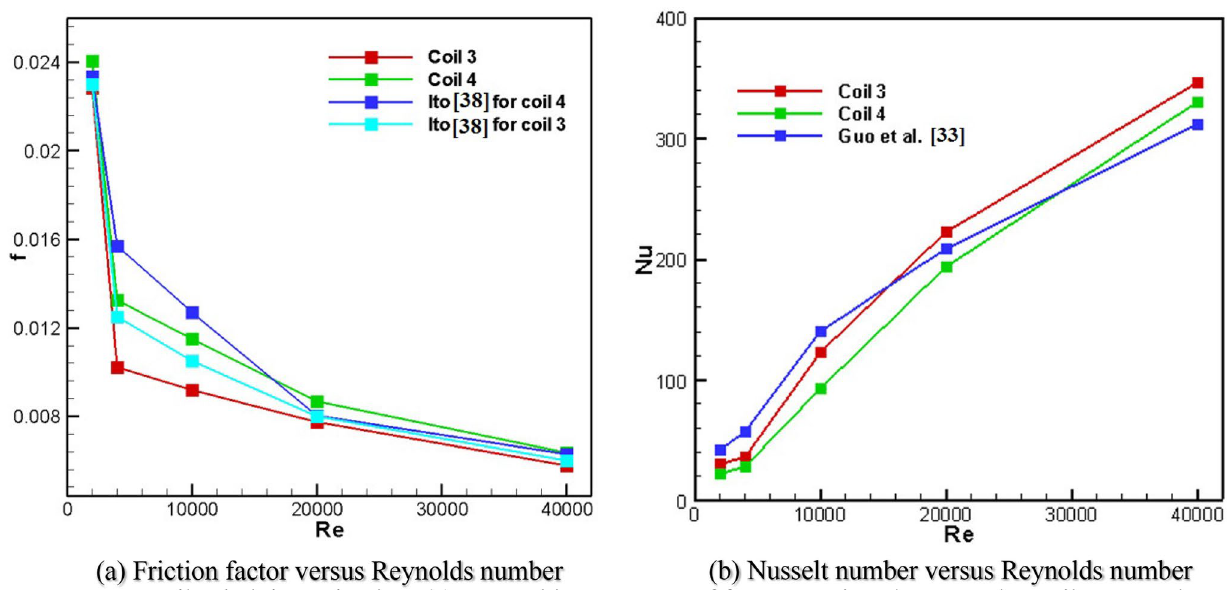
Fig. 12 Coils pitch investigation. a Reynolds number versus f for comparison between the Coil No.3 and No.4 with Ito [38]. b Reynolds num- ber versus Nusselt number for comparison between the Coil No.3 and No.4 with Guo et al.